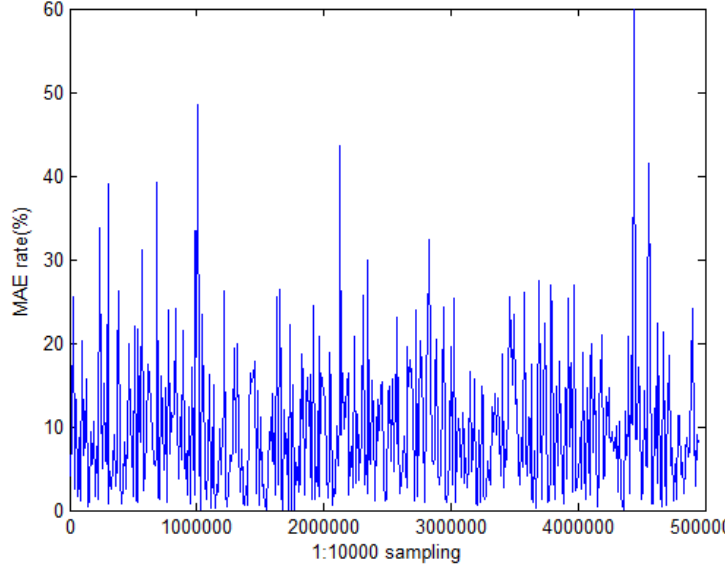
Fig. 3. MAE rate distribution of F 30 neural networks atmospheric model